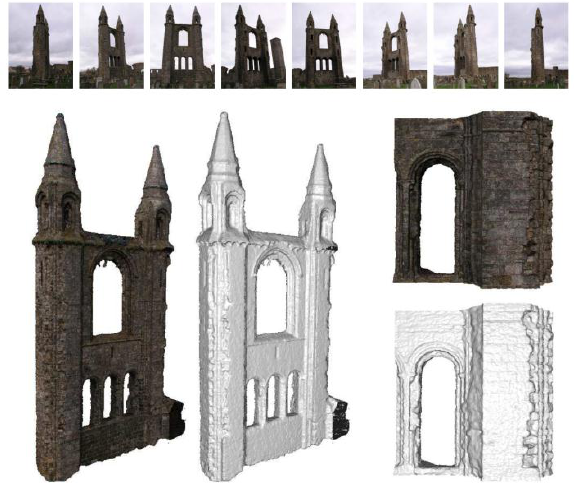
Figure 1: Church ruin St. Andrews, Scotland. 43 images with 5 Megapixels acquired in a circle around the object. Left: point cloud from dense image matching, right: meshed surface derived by volumetric range